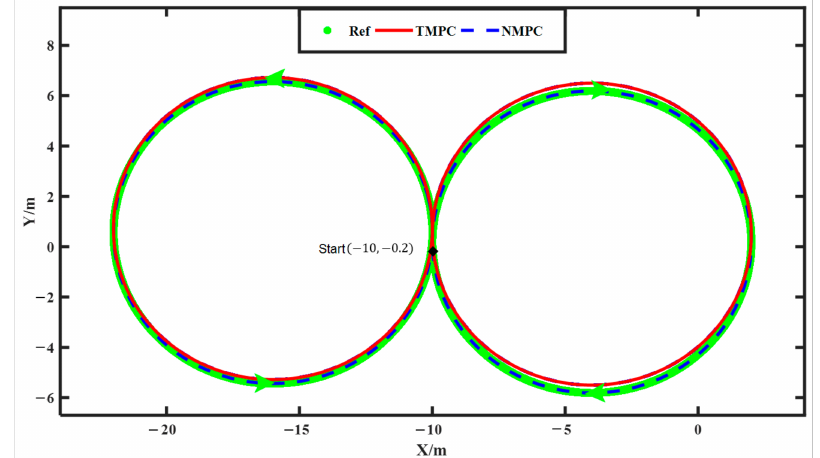
Figure 9. The simulation tracking results under the TCT.